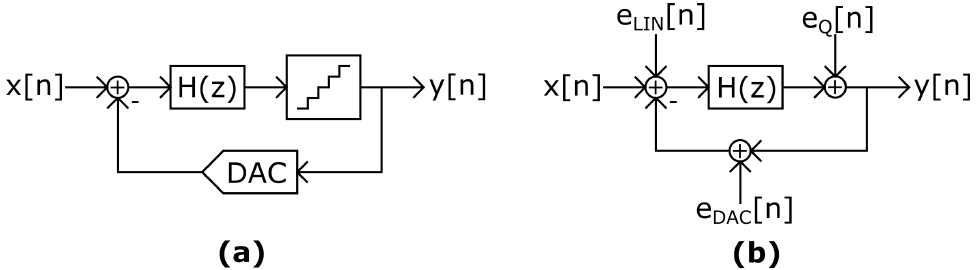
Figure 2. ( a ) System-level model of a DT- Σ∆ M. ( b ) Linear model of IBN power increase in DT- Σ∆ M with low-frequency input